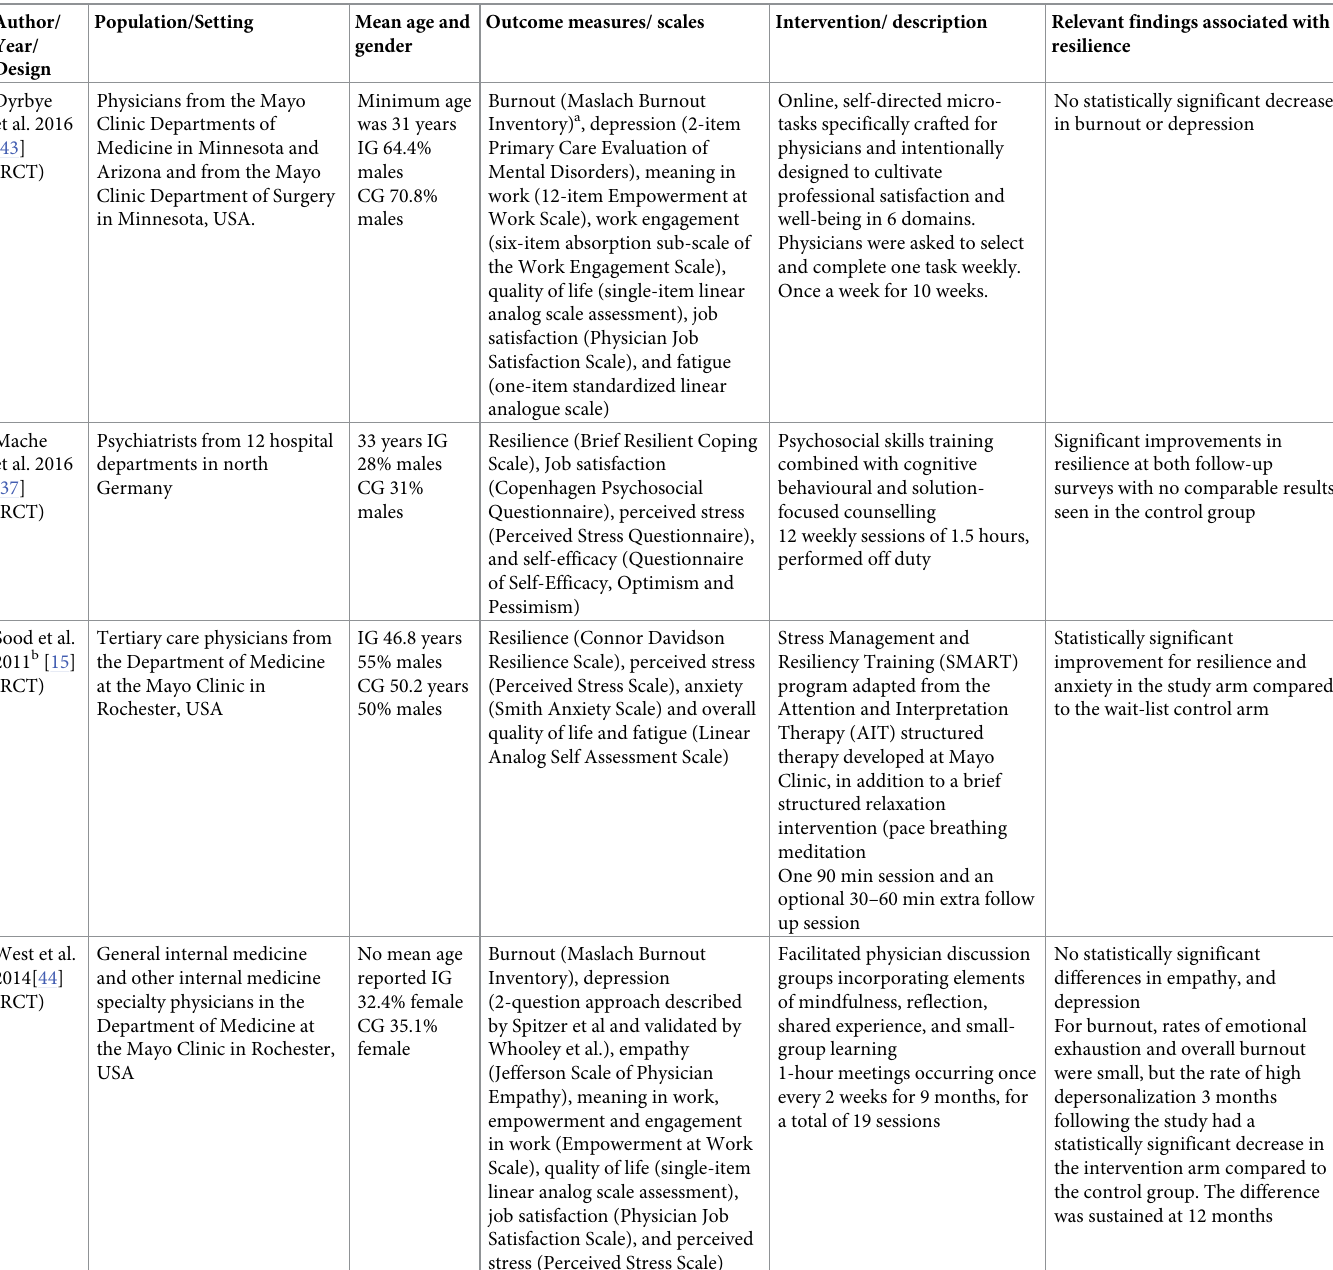
Table 1. Summary of clinical characteristics of studies including results specifically for physicians in randomized controlled